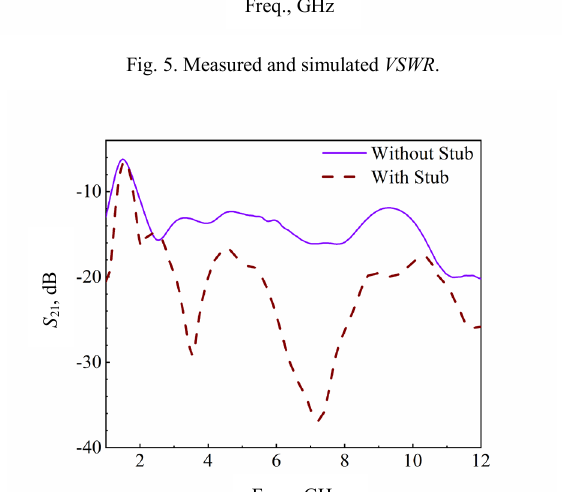
Fig. 6. S 21 without and with a stub.